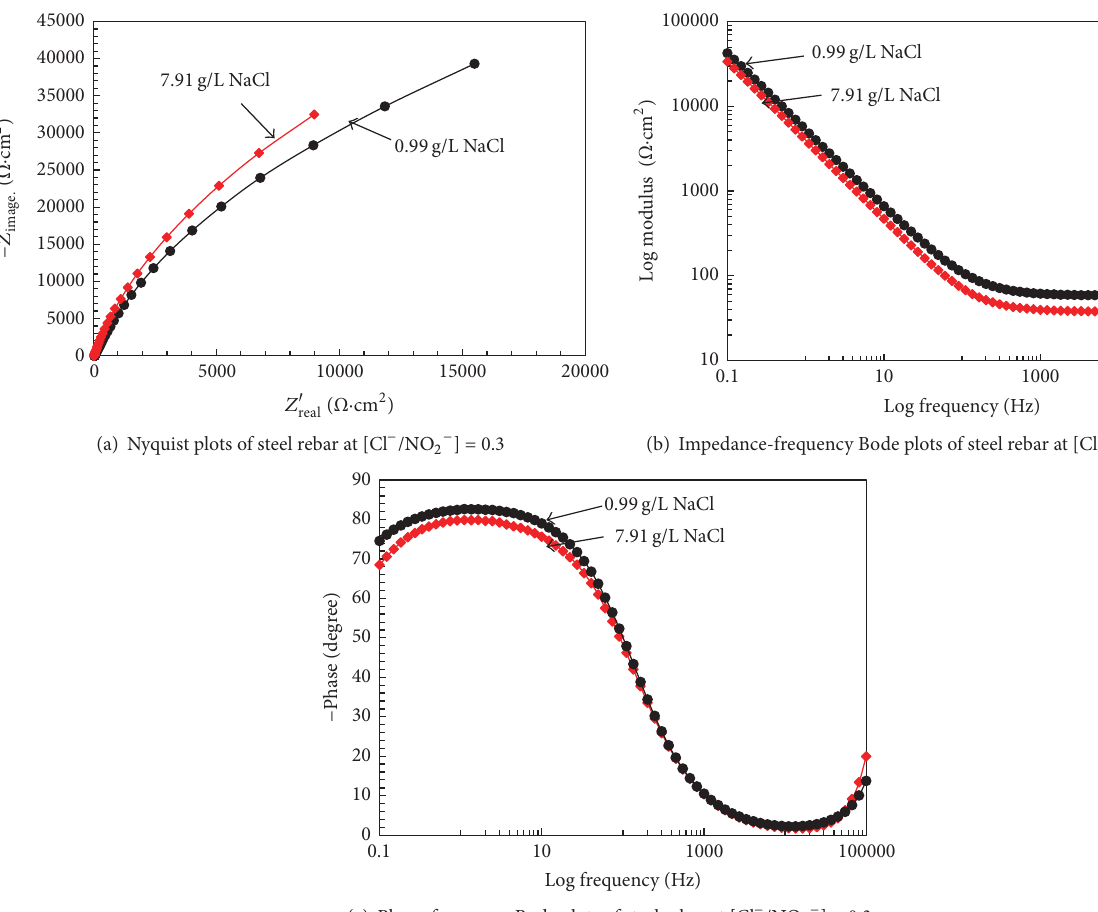
(c) Phase-frequency Bode plots of steel rebar at [Cl − / NO 2− ] = 0.3